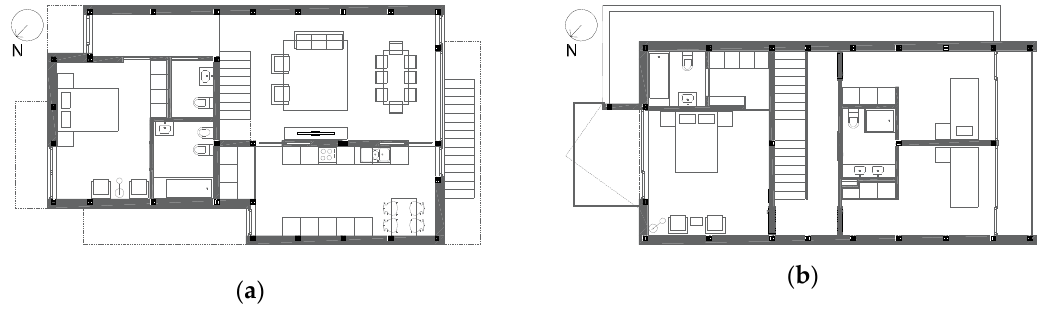
Figure 4. Architectural drawings of the building: ( a ) ground floor; ( b ) first floor.